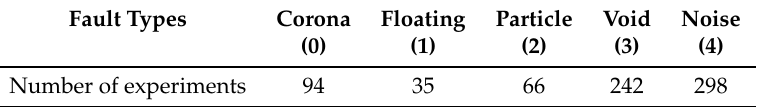
Table 1. Experimental